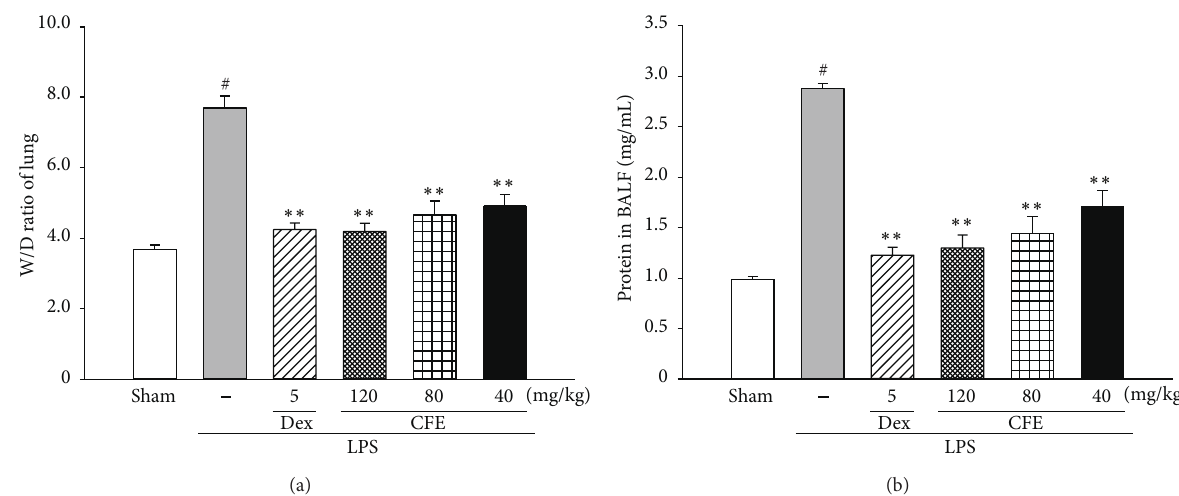
Figure 2: The effects of CFE on lung W/D ratio (a) and BALF protein content (b). Data was represented as the mean ± SEM ( 𝑛 = 10 ). # 𝑃 < 0.01 compared to the sham group; ∗ 𝑃 < 0.05 and ∗∗ 𝑃 < 0.01 compared to the LPS group.